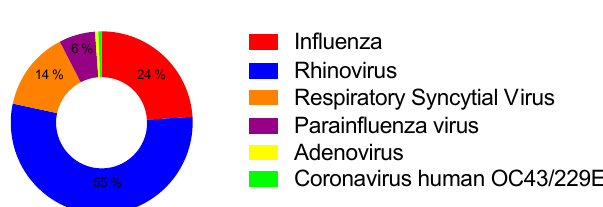
Figure 1. Percentage frequency of pathogens founded with the respiratory panel. This scheme shows the frequency according to the main respiratory microorganisms detected with the respiratory panel that cause acute respiratory infections in patients with negative RT-PCR result for SARS-CoV-2. We did not find any respiratory microorganisms in 50% of the evaluated samples. In children under five years, rhinovirus and parainfluenza were the most frequent etiologies; meanwhile, in those over 60 years, the most frequent were rhinovirus and influenza (Figure 2).